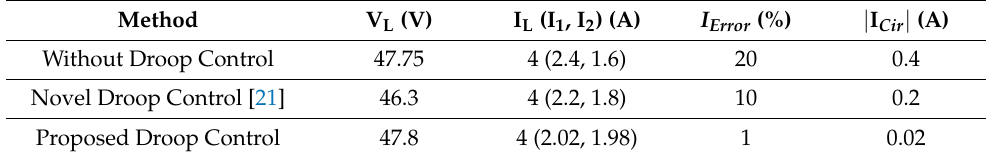
Table 6. Comparison of simulation results of different methods considering different cable resistances.